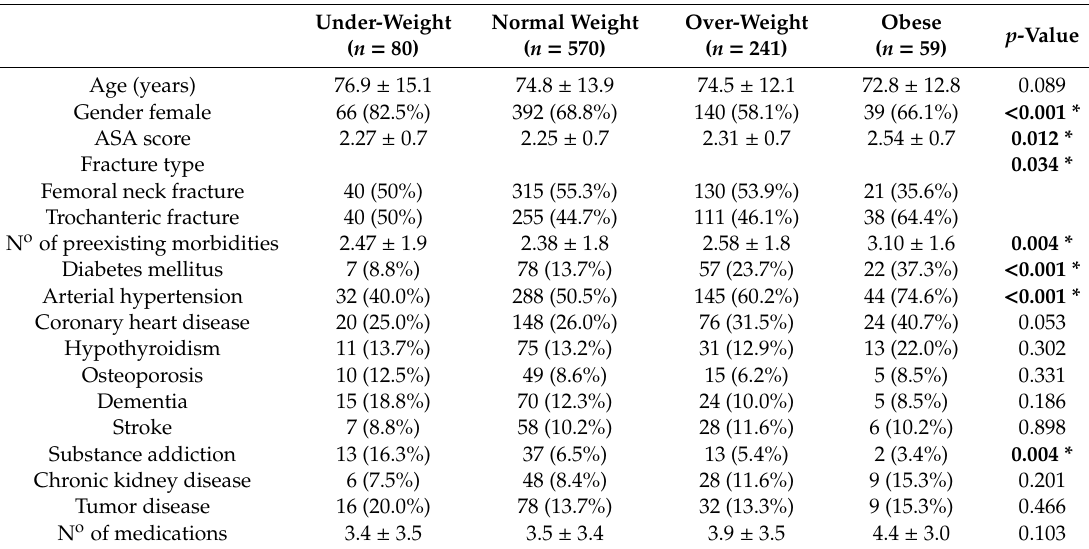
Table 3. Epidemiology and history of